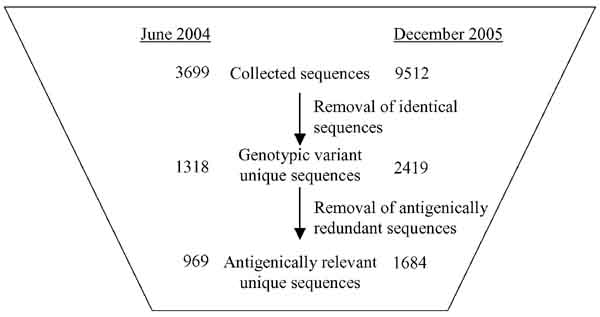
Flowchart summarizing the steps undertaken to identify the antigenically relevant unique sequence for dengue virus.